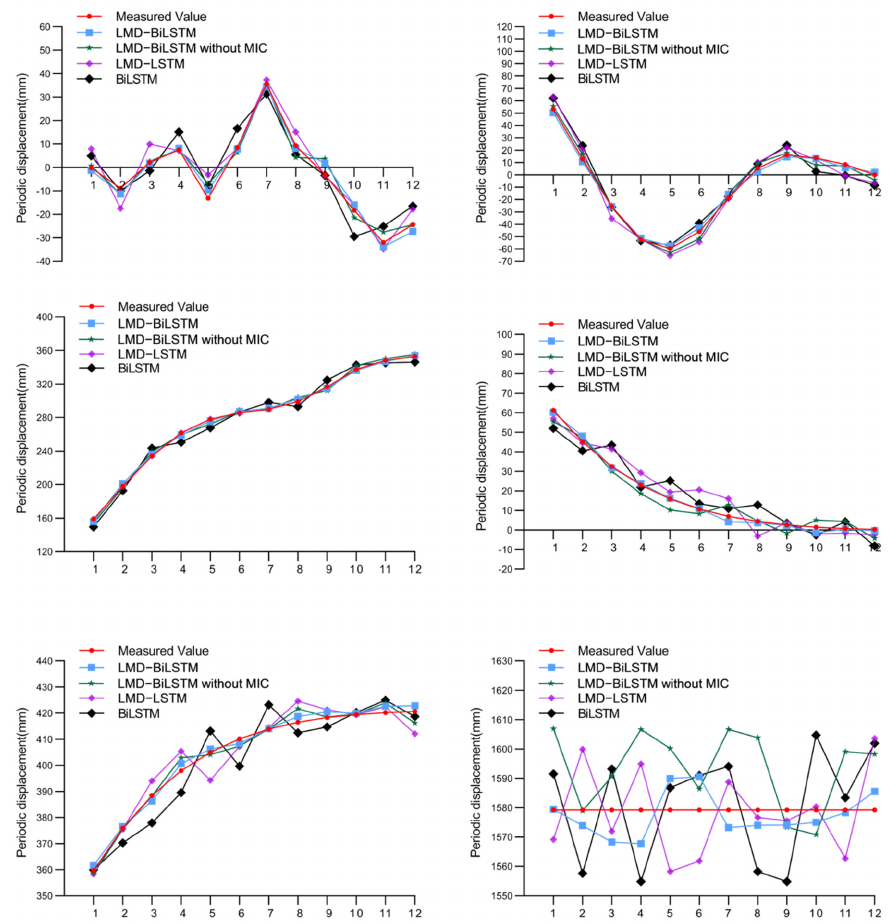
Figure 9. Comparison of the subsequence prediction results for landslide displacement based on four models. After obtaining five 𝑃𝐹 components and 𝑢 (cid:3038) components, the final prediction result is obtained by adding the subsequence prediction results of these models. To make a bet- ter comparison, the BiLSTM model is added to compare the final landslide displacement prediction results. The comparison of the final landslide displacement prediction results is shown in Figure 10.